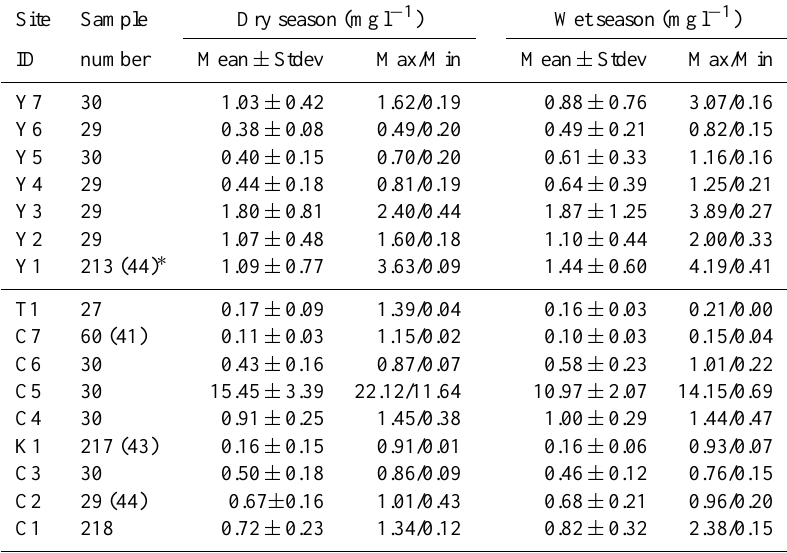
∗ The number in parentheses indicates the typhoon samples.